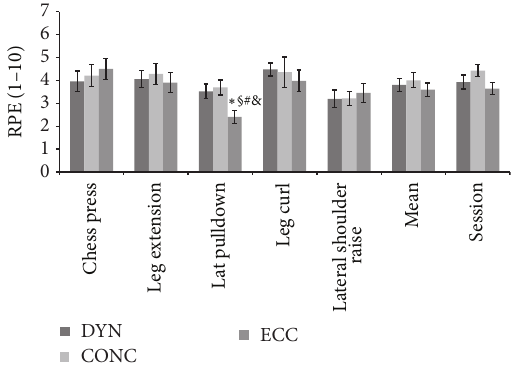
Figure 1: Significant differences: ( ∗ ) Chess Press × Lat pulldown; (§) LegExtension × Latpulldown;(#)Mean × Latpulldown;(&)Session × Lat